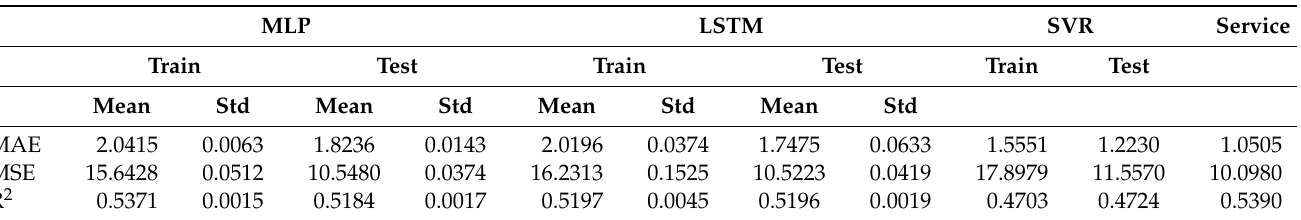
Table 13. Comparison of the effectiveness of the MLP model, two other models, and the weather service in forecasting the daily precipitation